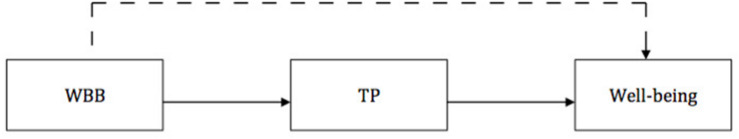
Accumulation model; WBB, well-being booster; TP, times perspective. Dashed line indicates that mechanisms other than given TP may in parallel mediate the effect.